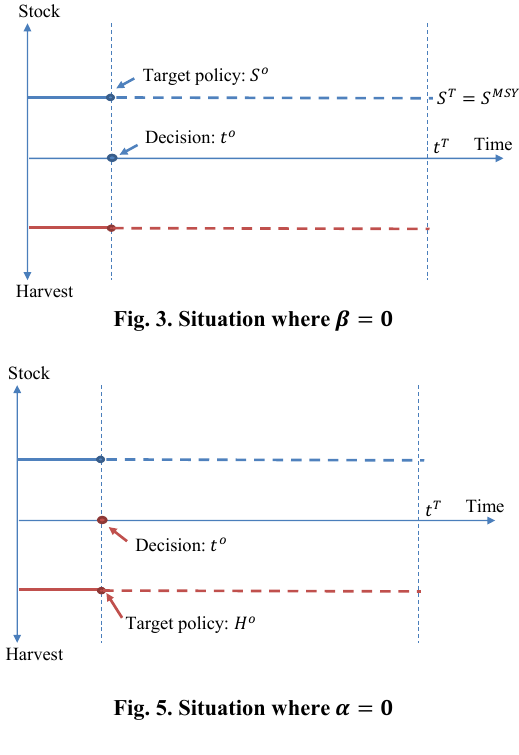
Fig. 2. Situation where